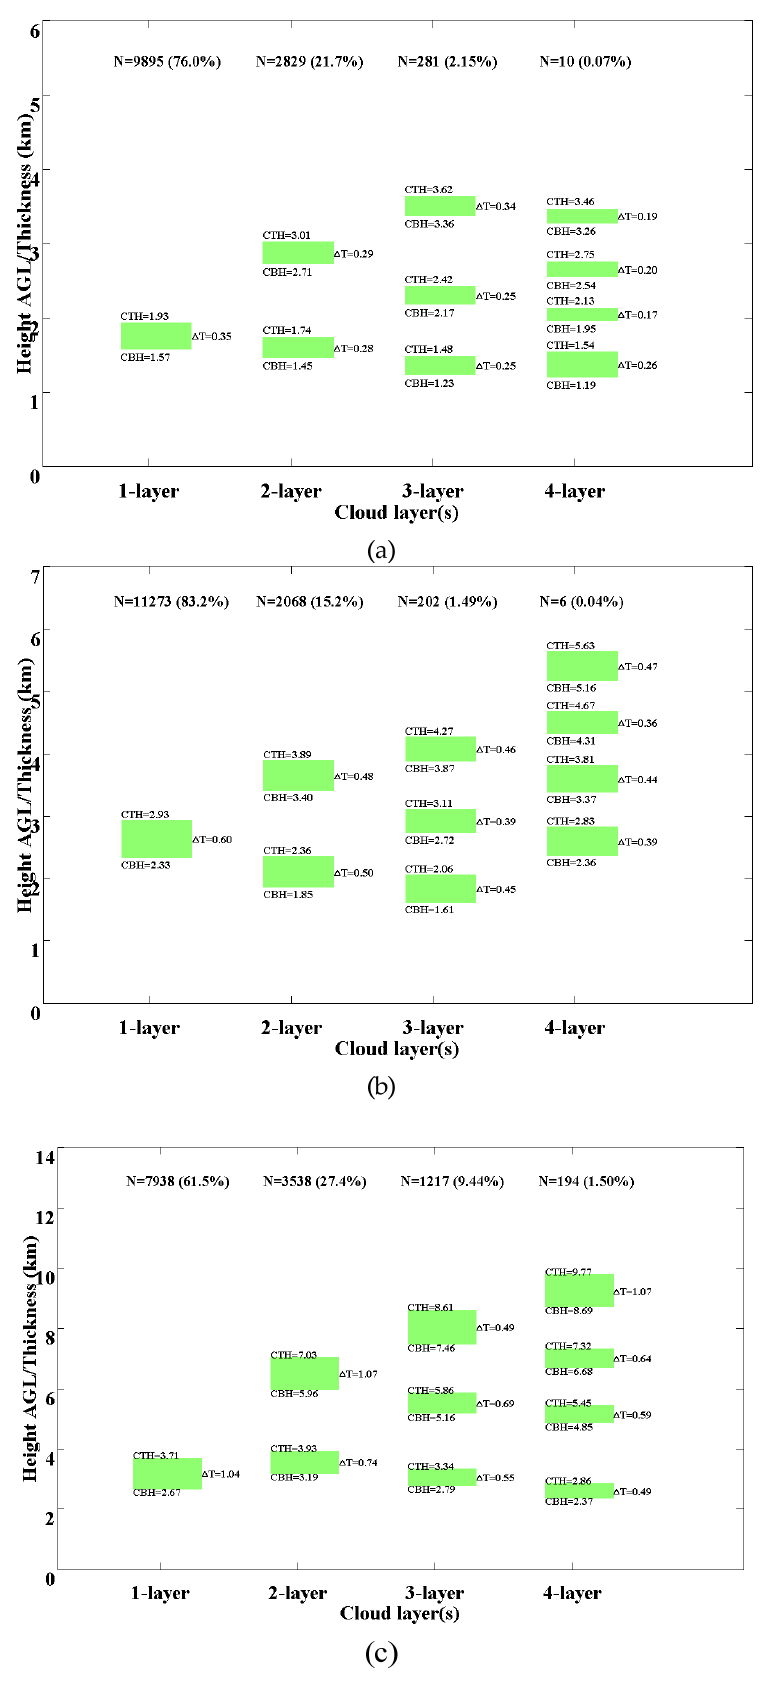
Figure 14. Averaged spatial distribution of one-, two-, three-, and four-layer clouds measured by WACAL at: ( a ) forenoon (10:00–12:00); ( b ) afternoon (16:00–19:00); and ( c ) night (20:00–22:00).